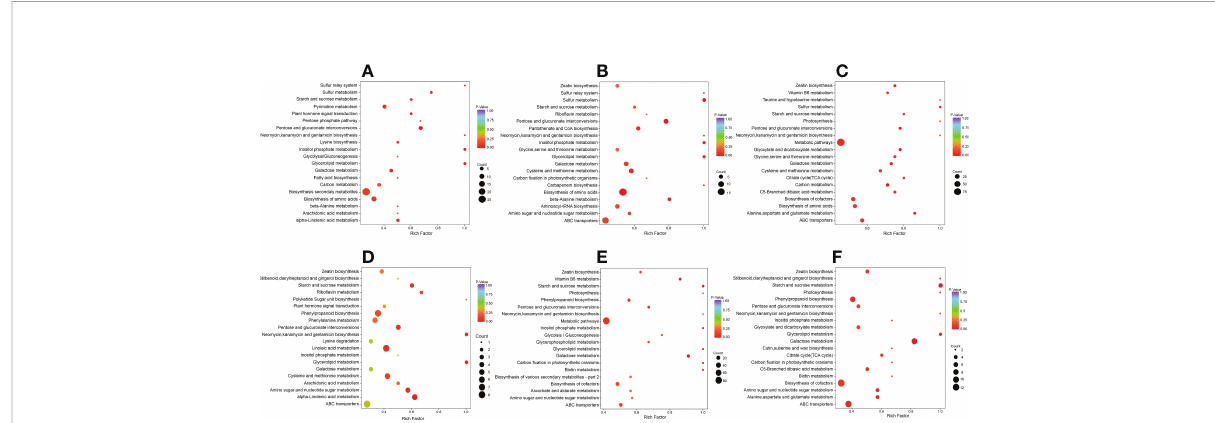
FIGURE 3 Scatter plot of DAMs for KEGG enrichment analysis. (A) The comparison group of 0 h vs. 1 h. (B) The comparison group of 0 h vs. 12 h. (C) The comparison group of 0 h vs. 24 h. (D) The comparison group of 1 h vs. 12 h. (E) The comparison group of 1 h vs . 24 h. (F) The comparison group of 12 h vs. 24 h. The vertical coordinate indicates the KEGG pathway. The horizontal coordinate represents the rich factor (the ratio of the amount of DAMs abundant in the pathway to the amount of annotated metabolites), the larger the rich factor, the greater the enrichment, the smaller the P value, and the more signi fi cant the enrichment. The larger the dot, the greater the amount of DAMs enriched in the pathway. The redder the color of the dot, the more noticeable the enrichment. We selected the 20 most signi fi cantly enriched pathway entries for display in this fi